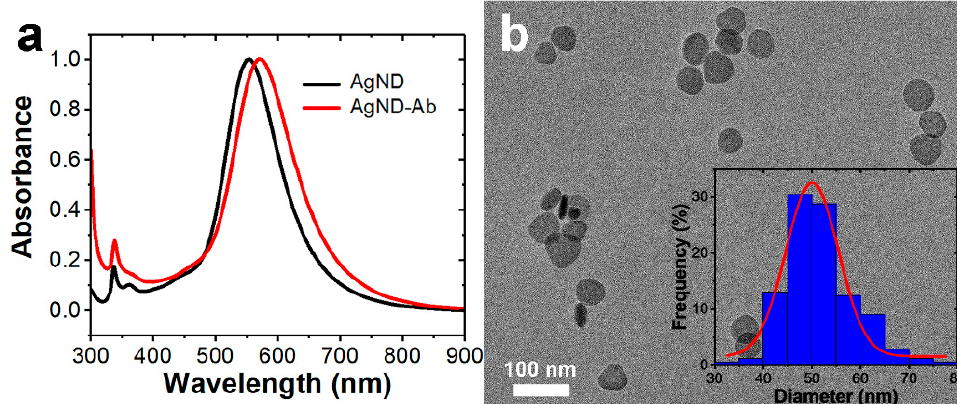
Figure 2. ( a ) UV − vis spectra of solutions of as-prepared AgNDs and AgND-Ab conjugates. All spectra were obtained in 1.0 mM sodium citrate solution using a 50.0 µL cuvette having a 1.00 cm pathlength. ( b ) Representative TEM image showing the AgNDs after modification with Abs (AgND- Abs). The inset is a histogram of AgND diameter obtained by measuring 200 randomly selected AgND-Ab particles. The AgND-Abs were prepared in the presence of PVP but in the absence of Cl − . They were dispersed in a 10.0 mM sodium citrate solution.